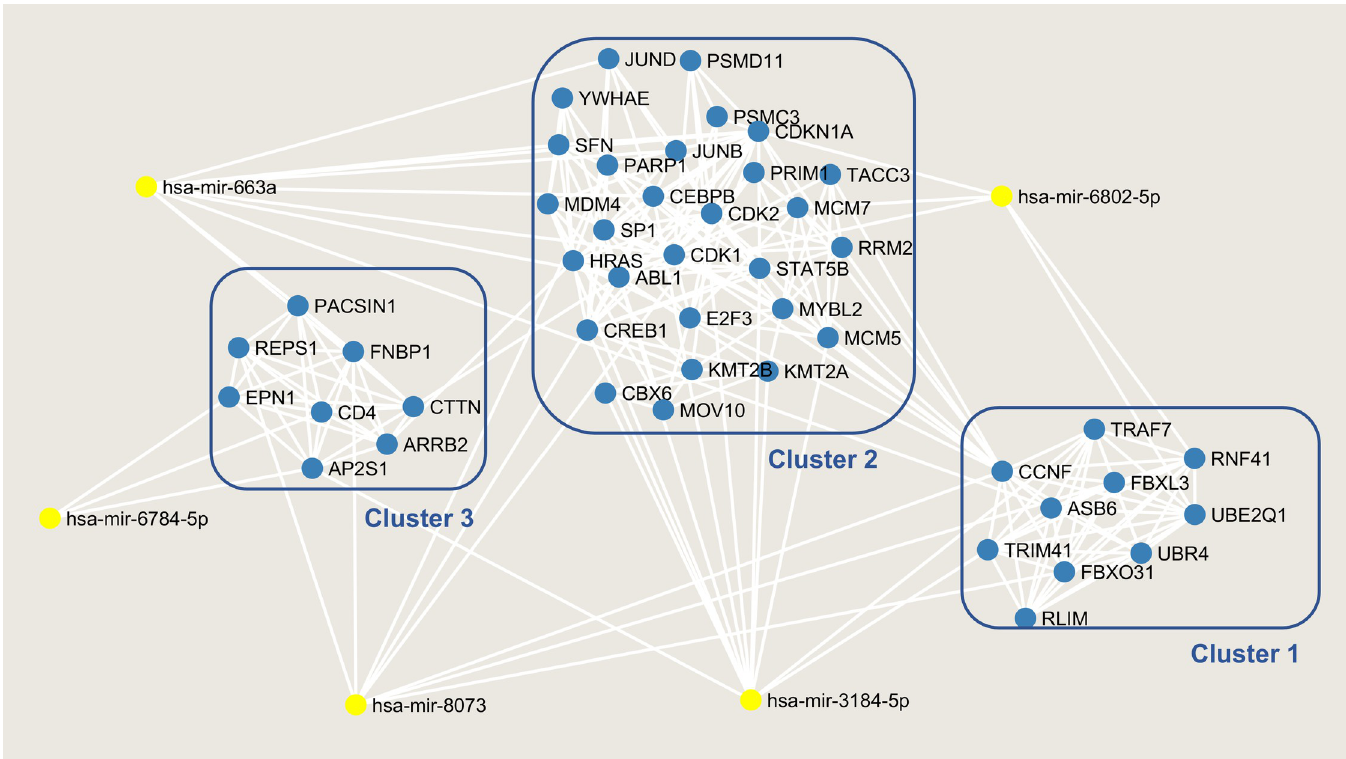
Fig 5. Cluster analysis of the mRNA presented in the miRNA-mRNA interaction network. Top clusters with MCODE value > 5 from cytoscape were chosen and the clusters along with their interactions with the 5 selected miRNAs were shown. The miRNAs are highlighted in yellow, and the mRNAs are in blue.